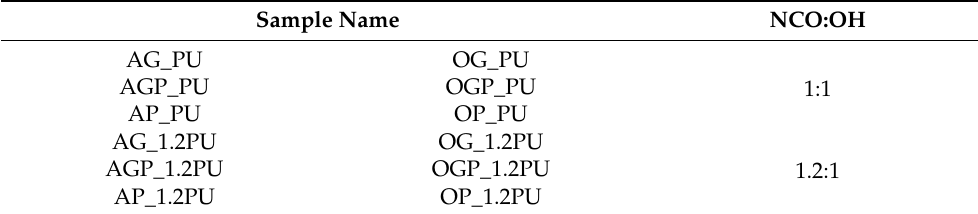
Table 2. An explanation of the abbreviations used to describe polyurethane